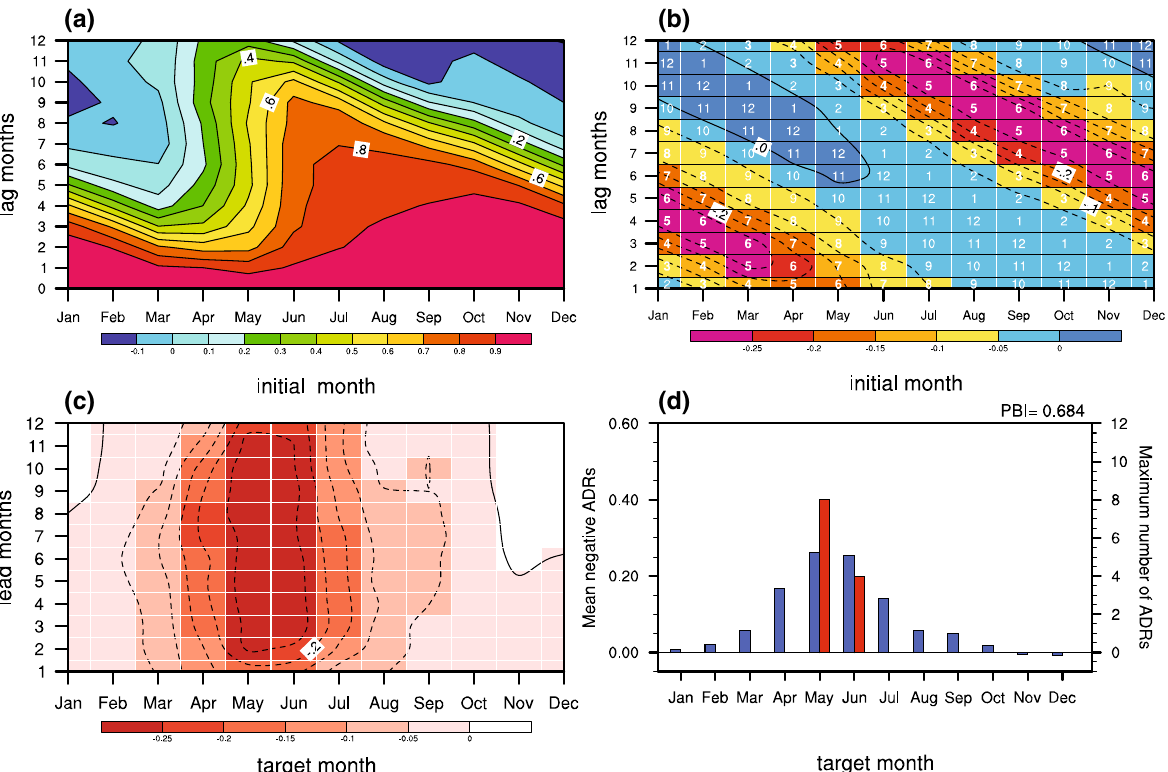
Fig. 1 a Autocorrelation as a function of initial calendar month (x axis) and lag month (y axis) for the Niño3.4 index. b Autocorrelation decline rates (ADRs) in ( a ). Values of the rate are plotted in contours and shaded boxes, respectively, where the interval is 0.05. White numbers in shaded boxes denote the target calendar month in the lag month domain. c ADRs as a function of target calendar month and lead month for the Niño3.4 index, where the interval is 0.05. d Mean ADRs for all 12 lead months (left y axis: blue bar) and the frequency of the maximum ADRs (right y axis: red bar) as a function of the target calendar month (x axis) for the Niño3.4